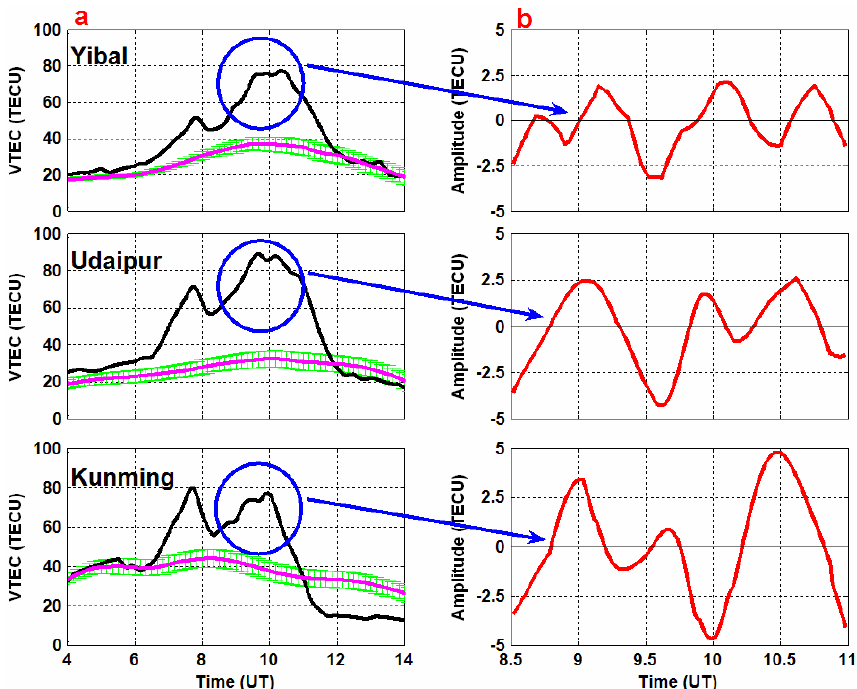
Fig. 2. (a) Variation of averaged storm day VTEC (in black) computed using data from satellites having elevation angle greater than 40 ◦ at Yibal, Udaipur and Kunming. The quiet day mean VTEC (in magenta) is also plotted with 2 σ variations in green. Significant modulations of VTEC around the second enhancement (enclosed by an ellipse) are clearly observable and have been attributed to TADs. (b) Amplitude and period of TEC modulations observed from 08:30UT to 11:00UT. These have been computed by fitting a polynomial to the VTEC variation of Fig. 2a and differencing it from the actual VTEC variation at each station. Maximum amplitude of ± 5TECU is